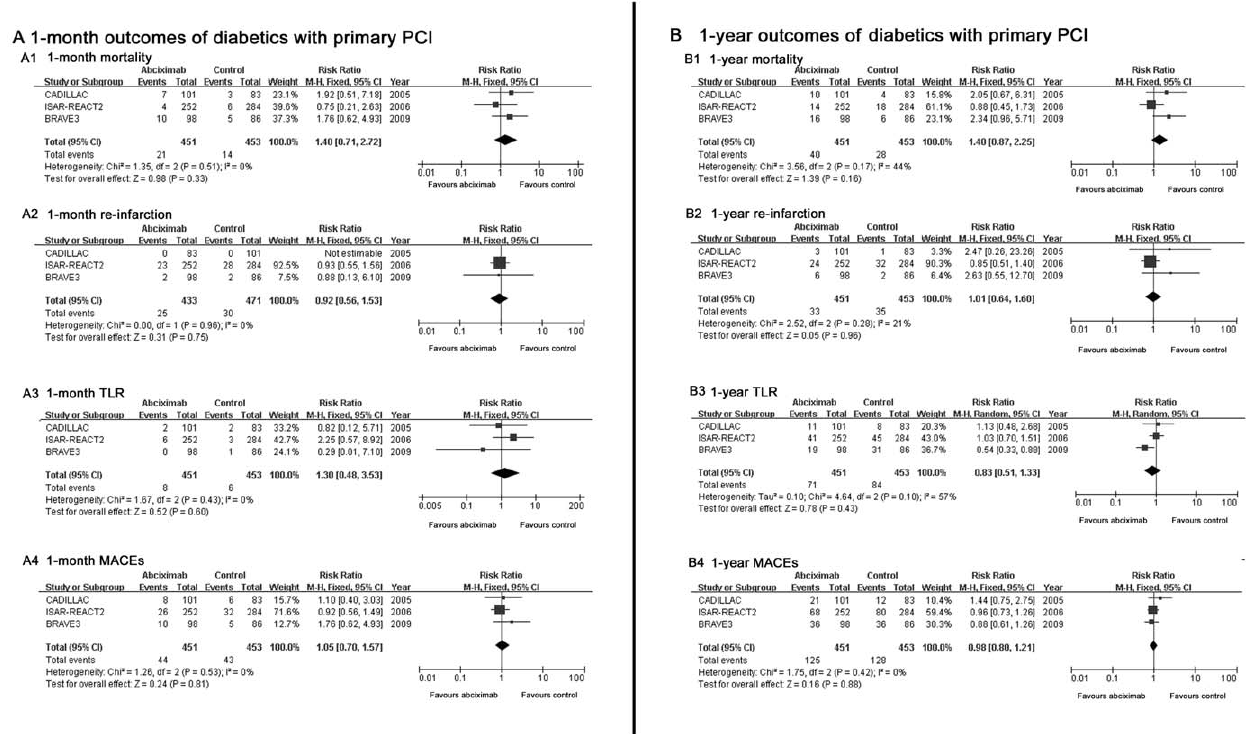
Figure 3. Comparison of 1-month and 1-year outcomes between abciximab and control group in patients with primary PCI. Efficacy of abciximab compared with control for (A1): 1-month mortality and (B1): 1-year mortality; (A2): 1-month reinfarction and (B2): 1-year reinfarction; (A3): 1-month TLR and (B3): 1-year TLR; (A4): 1-month MACEs and (B4):1-year MACEs in diabetic patients with primary PCI.